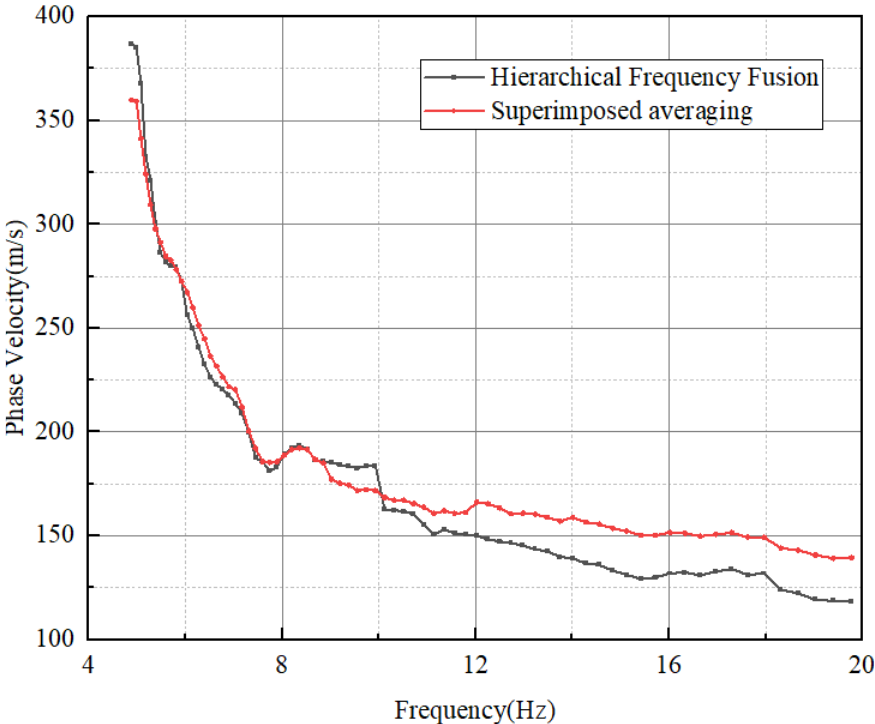
Figure 13. Dispersion curves of hierarchical frequency fusion and superimposed averaging method.